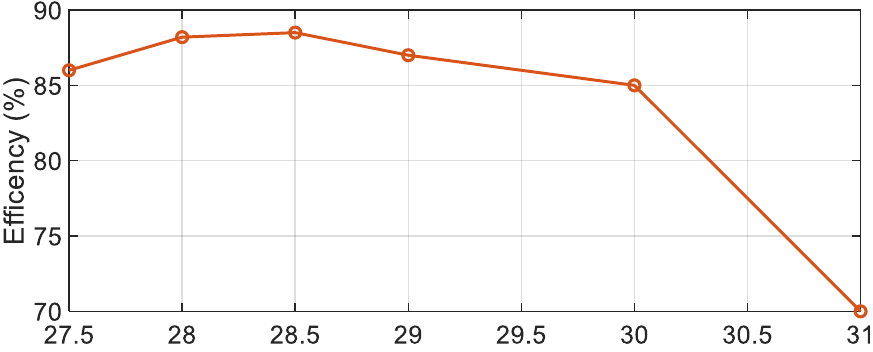
Figure 19. Measured radiation efficiency for the proposed CDRA antenna array.